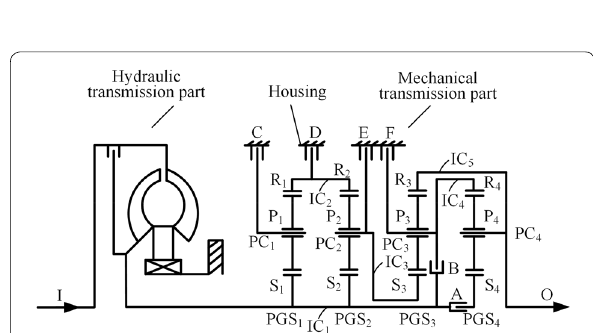
Figure 9 Structural diagram of the AT mechanism